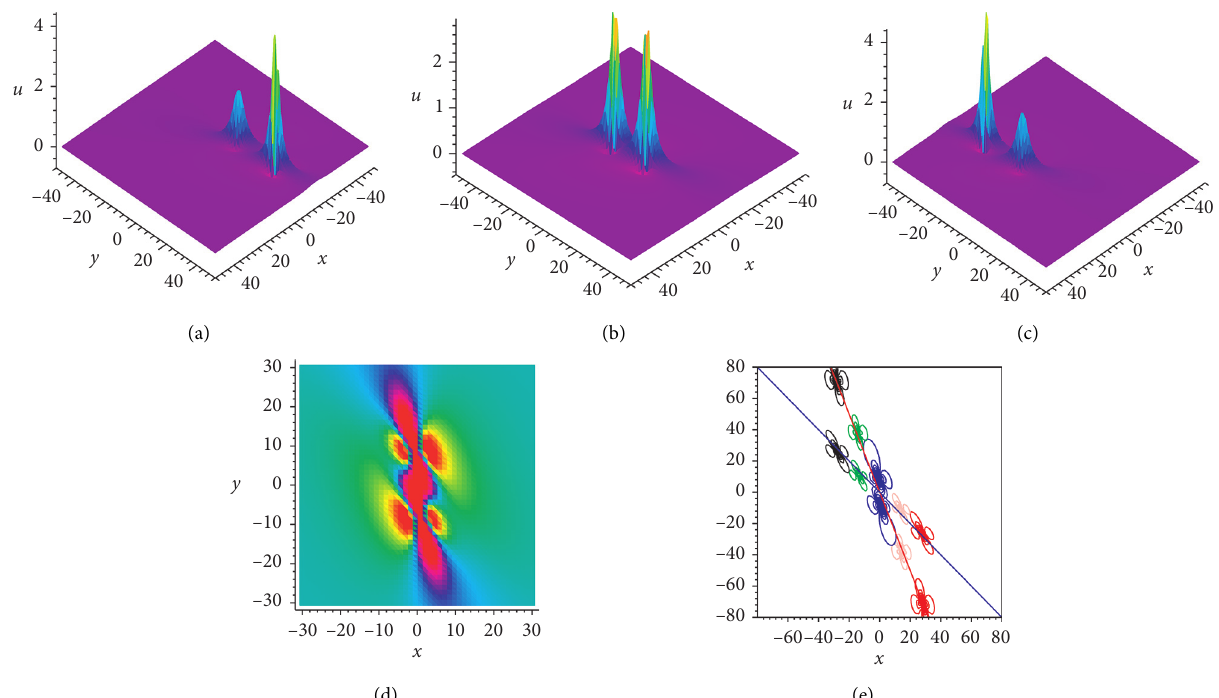
Figure 4: Evolution graphs of second-order lump solution: (a), (b), (c) three-dimensional plot at t � − 5, t � 0, and t � 5, (d) density plot at t � 0, and (e) the contour plot at t � − 14 (black), t � − 7 (green), t � 0 (blue), t � 7 (pink), and t � 14 (red) about the moving path described by the blue line y � − x and red line y � − ( 5/2 ) x .